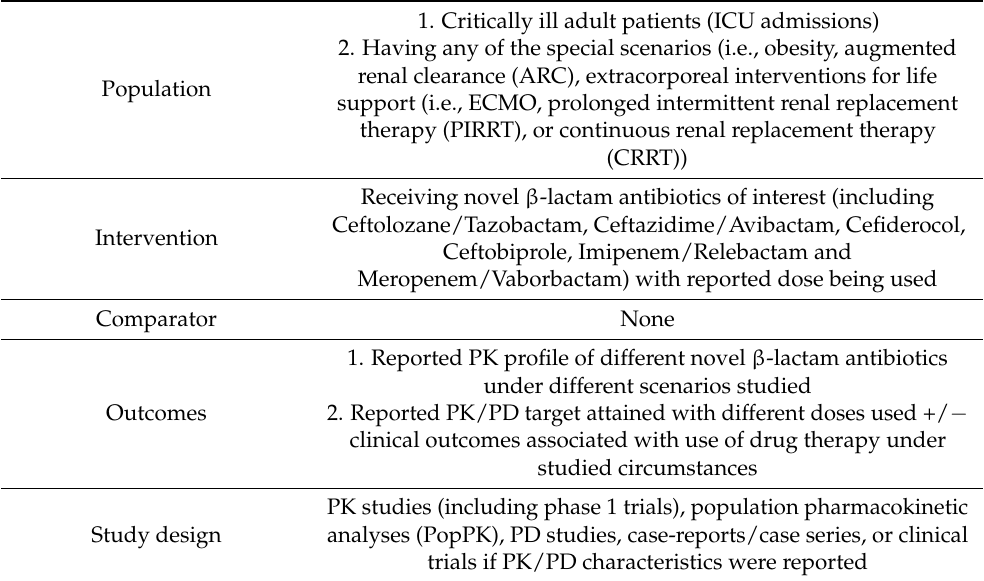
Table 1. Eligibility criteria for the included